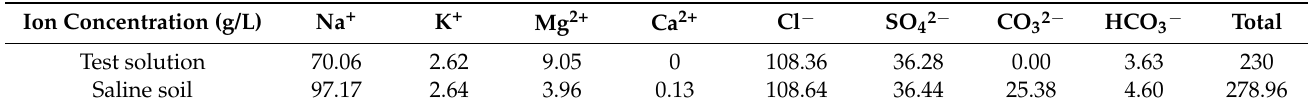
Table 5. Ion concentration in saline soil and the test